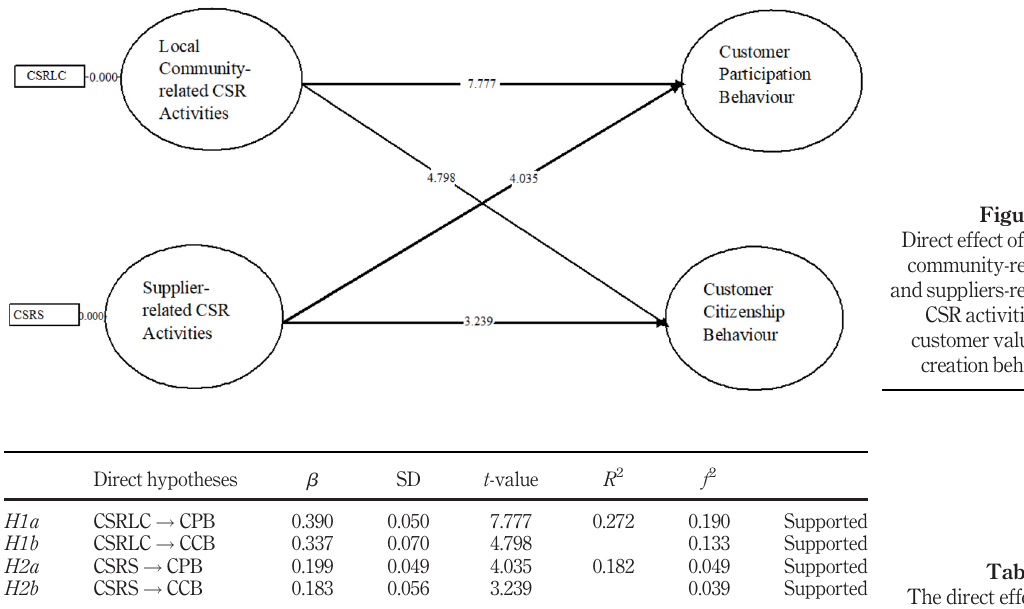
Table 4. The direct effect